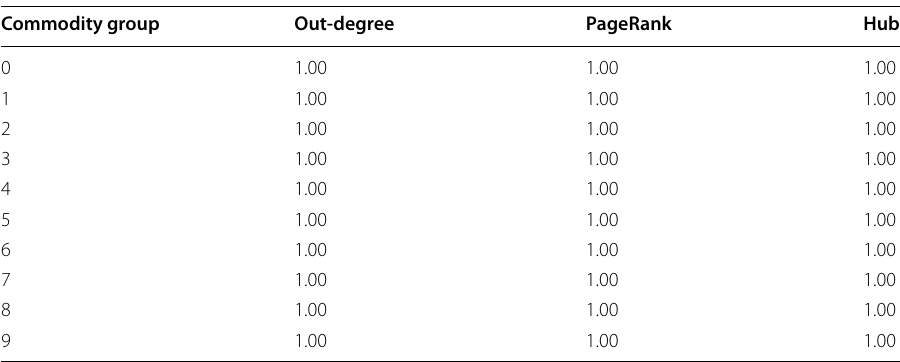
Table 7 Test of the similarity between two correlation coefficients in the two pairs of networks in case 2, in export sector